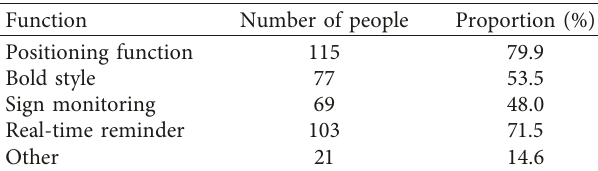
Figure 11: Neck size of different algorithms: (a) Experimental result of cuff. (b) Experimental result of neck circumference. Table 2: The functions expected of children’s clothing. Table 3: The functions expected of outdoor worker